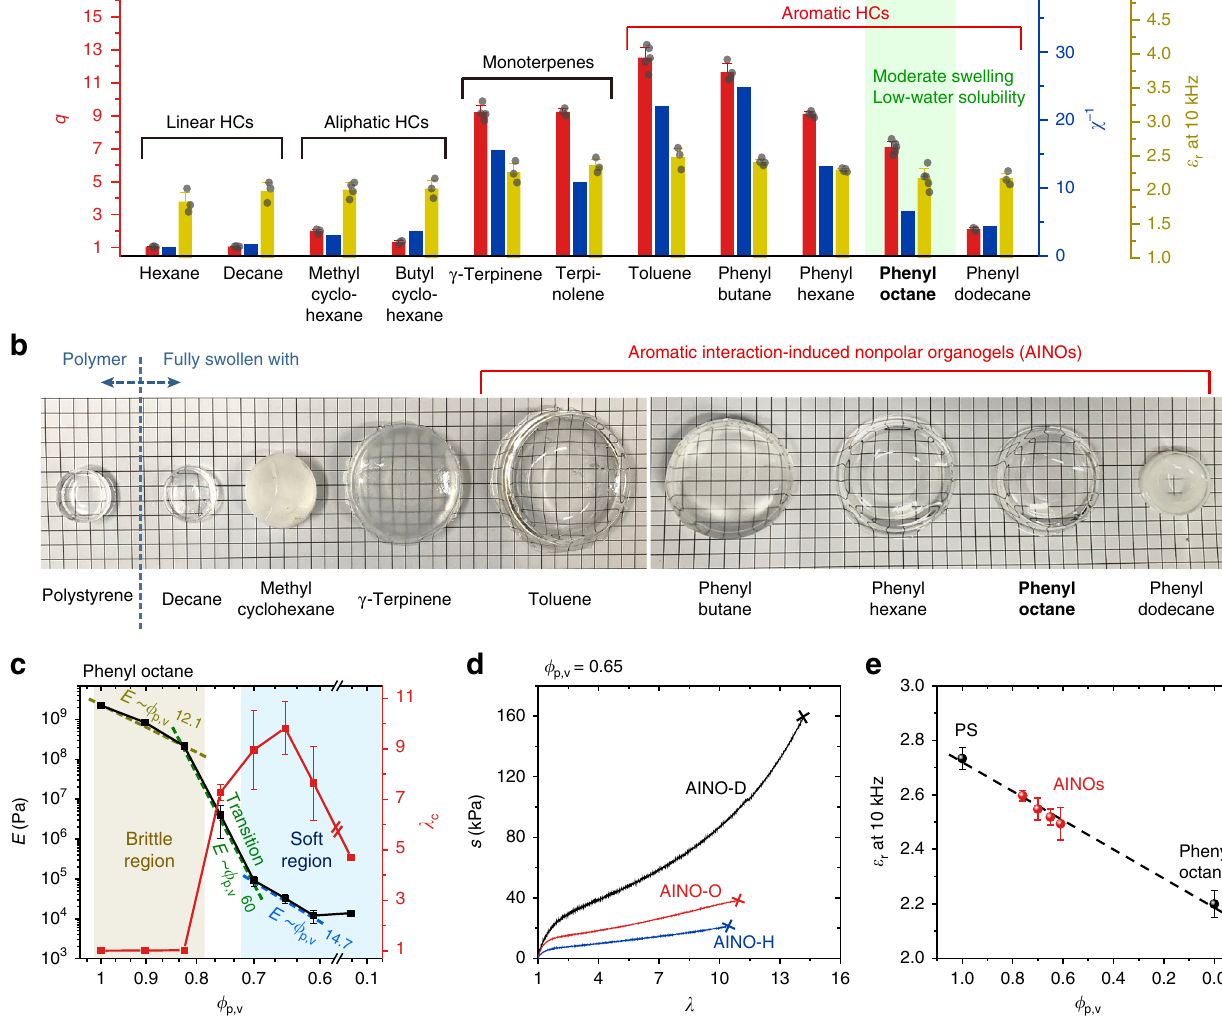
Fig. 2 Materials investigation for nonpolar organogels. a Swelling ratio (red columns) and polymer – solvent interaction af fi nity of various hydrocarbon (HC) solvents with polystyrene (blue columns), and their static dielectric constant at 10 kHz (yellow columns). b Photographs of initial polystyrene (PS) and PS organogels fully swollen with various HC solvents. Phenyl octane is chosen as a main solvent component for the AINO, due to its moderate swelling, low dielectric constant, and water solubility. c Elastic modulus and rupture stretch of the AINOs based on phenyl octane as a function of their polymer volume concentration from 1 to 0.153 (pure PS to fully swollen state). d Stress – stretch curves of the AINOs with different phenyl alkanes at polymer volume concentration of 0.65. e Static dielectric constant of the elastomeric AINOs and their constituents (PS and phenyl octane) at 10 kHz. Values in a , c , and e represent the mean and standard deviation ( n = 3 –